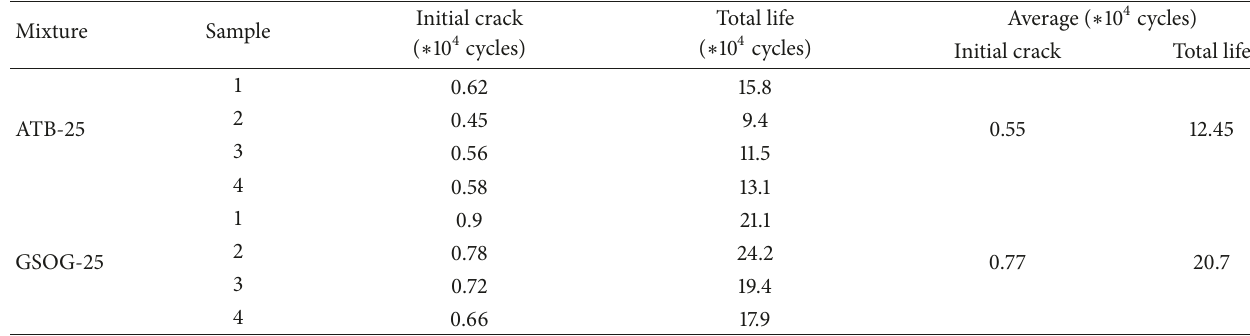
Table 19: Shearing type reflection